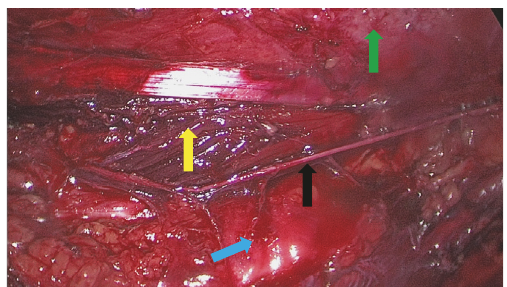
Figure 1: Perioperative view of the dissected proximal left gen- itofemoral nerve (GFN), just before neurectomy.Patient in right lat- eral decubitus position. Black arrow: GFN. Yellow arrow: musculus psoas. Green arrow: lateral abdominal wall. Blue arrow: